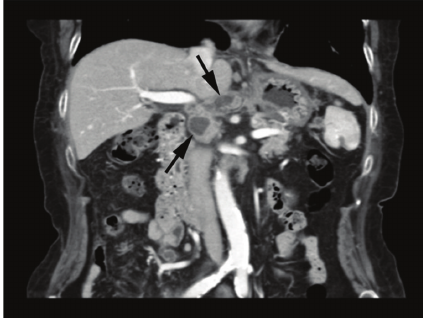
Figure 1: Abdominal computed tomography scan revealed multiple enlarged lymph nodes (arrows).